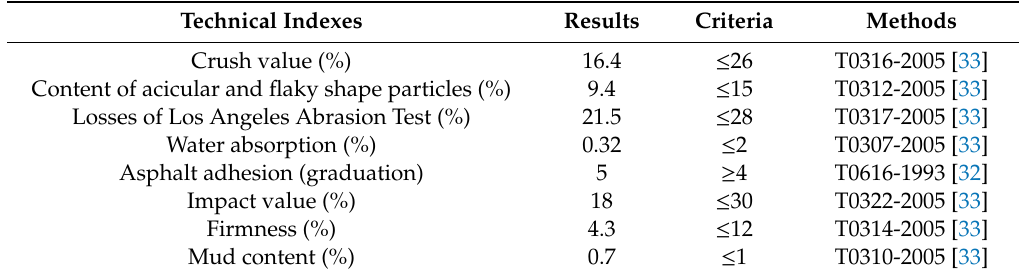
Table 2. The properties of coarse aggregates.